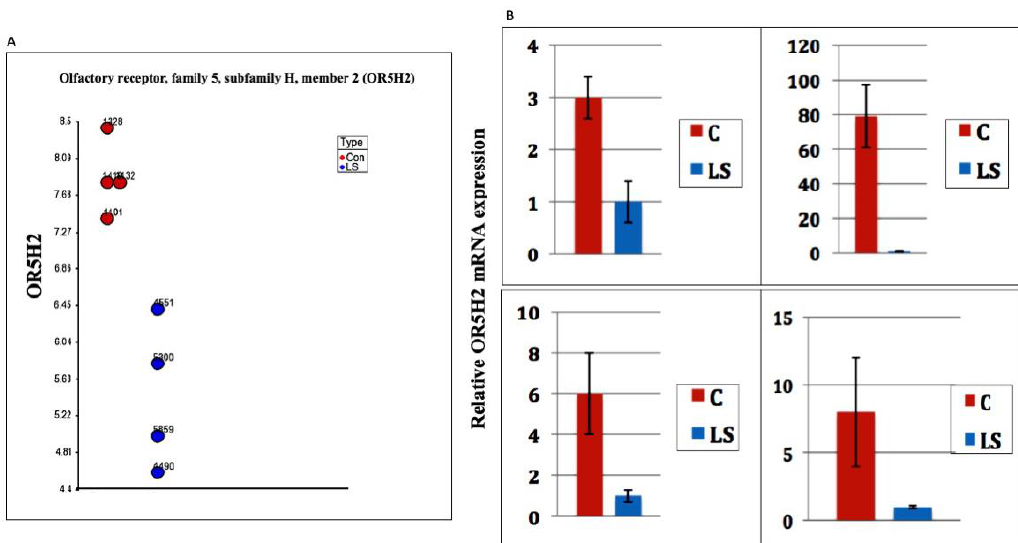
Figure 1. Expression of OR5H2 mRNA in the LS- and control-derived lymphoblastoid cell lines. ( A ) Dot-plot analysis of OR5H2 mRNA in lymphoblastoid cultures was conducted as described in Lapkina-Gendler et al. [19]. Dots denote individual LS patients (blue dots) and age-, gender- and ethnic-origin-matched controls (red dots). Numbers near each dot are code numbers. The y-axis denotes arbitrary gene expression values as measured in gene arrays. ( B ) Total RNA was obtained from four individual LS and four control lymphoblastoid cell lines and OR5H2 mRNA levels were measured by qPCR. The y-axis denotes the fold-change in gene expression between individual LS patients (blue bars) and matching controls (red bars). The bars represent the mean ± SEM of three independent cultures.